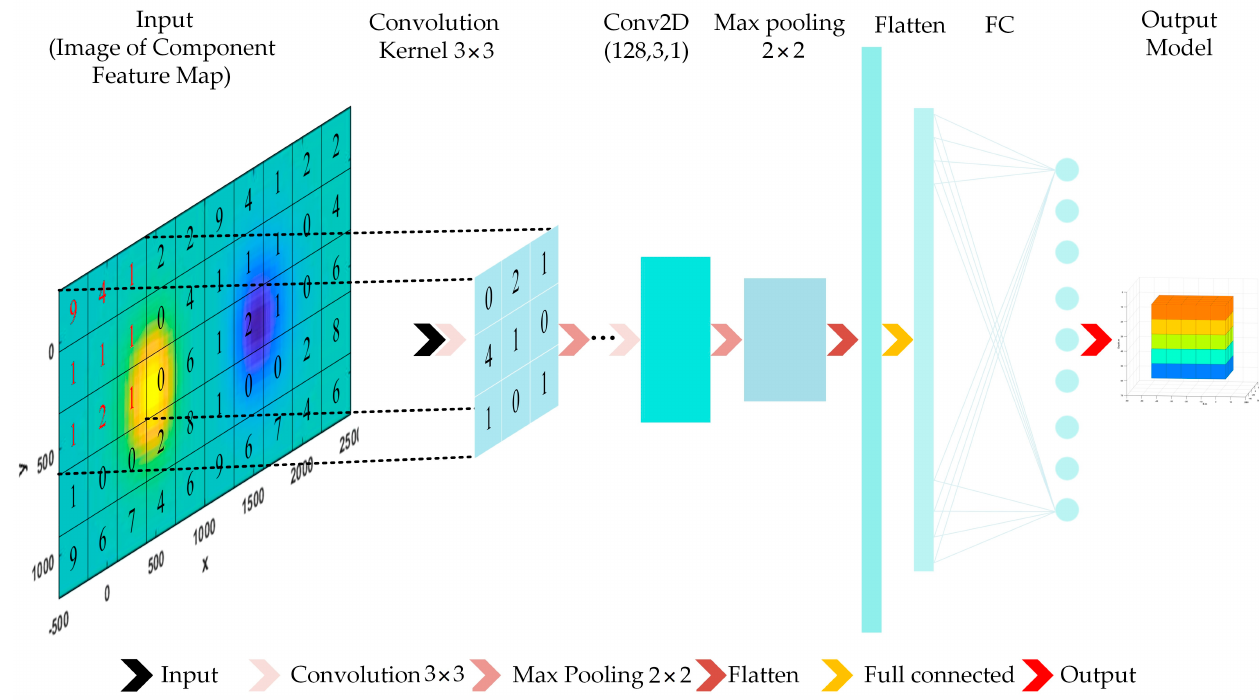
Figure 1. CNN framework